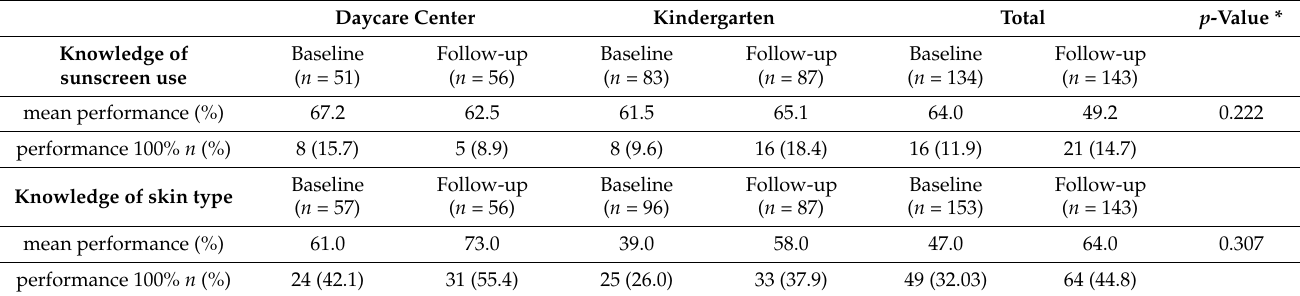
Table 1. Improvement in different knowledge traits, from baseline to follow-up